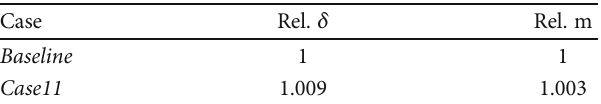
Figure 11: Di ff user pro fi les for di ff erent thicknesses. Table 7: Performance comparisons for di ff users with di ff erent thicknesses.